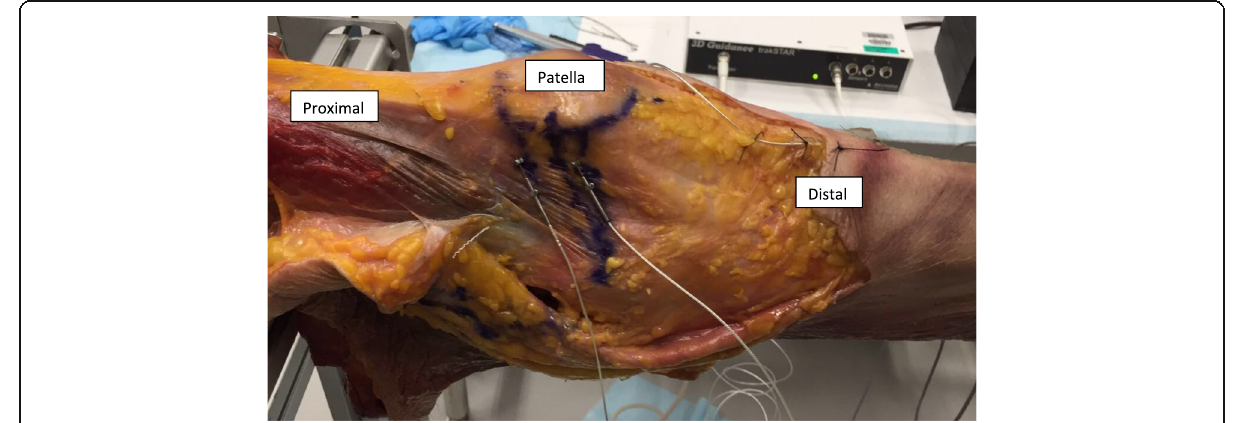
Fig. 3 DVRT attached to the native MPFL of left knee, Electromagnetic sensor attached distal to tibial